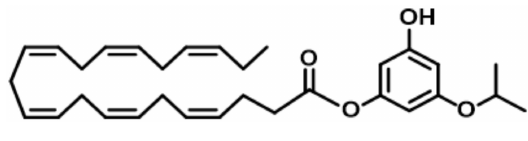
Figure 1. Structure of